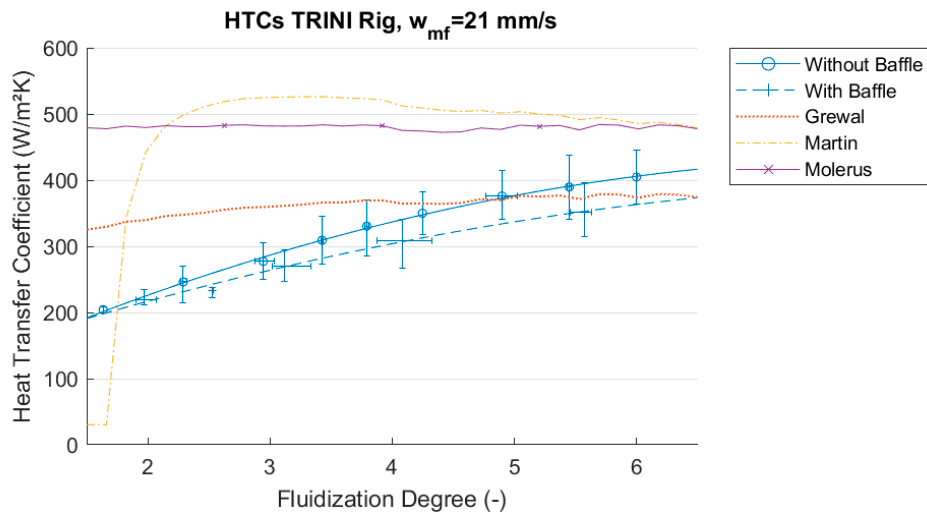
Figure 23. Comparison of LINI results, 146 µm particle.